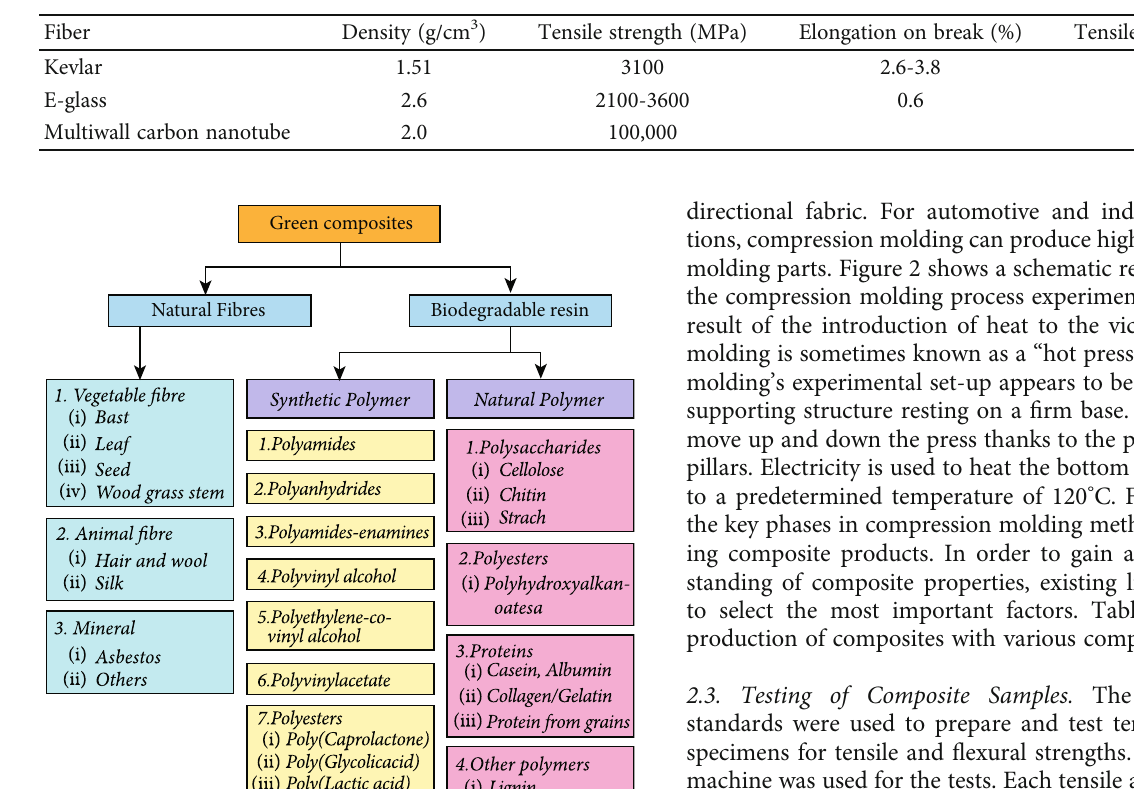
Table 1: Physical and mechanical characteristics of fi ller and fi bers materials [27].